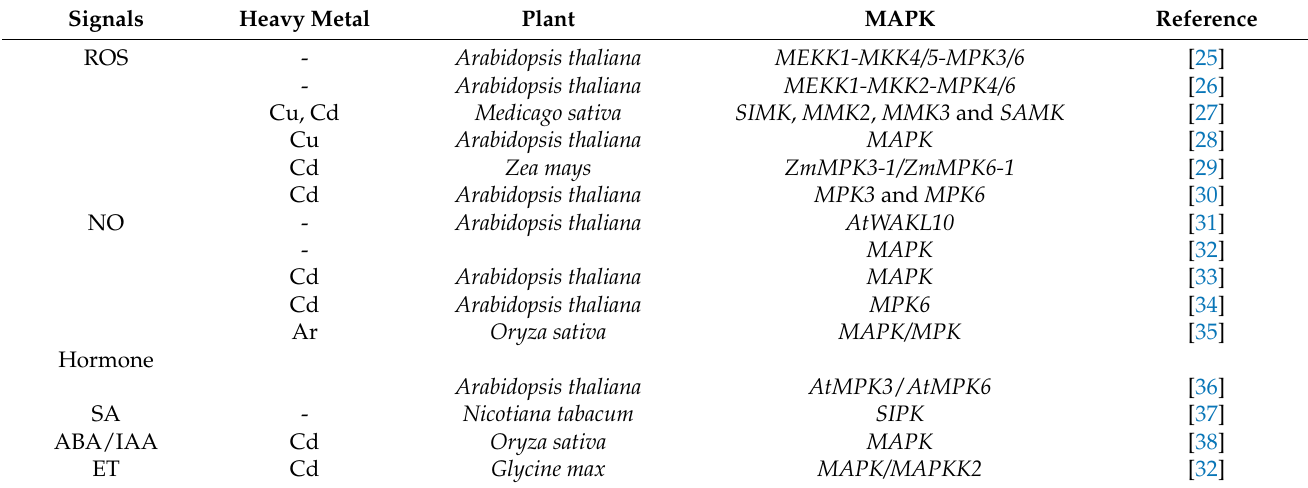
Table 1. Different signal molecules activate MAPK pathway under heavy metal